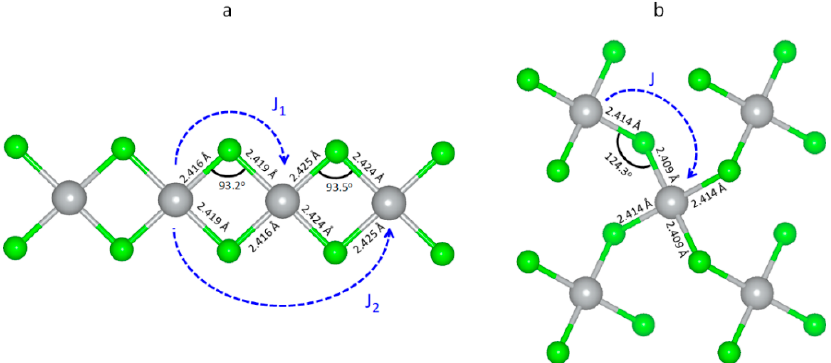
Figure 9. Fragment of the AgCl 2 ribbon with two relevant intra-chain superexchange constants considered in this study ( a ). Fragment of the corrugated AgCl 2 sheet with one relevant intra-sheet superexchange constant considered here ( b ).